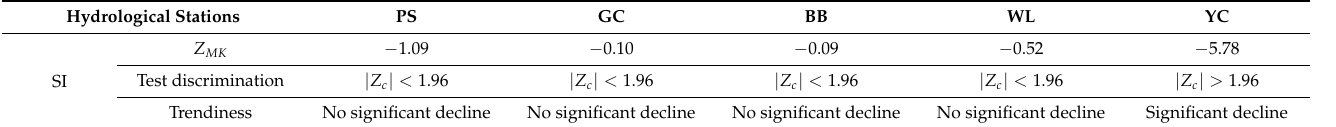
Table 4. TFPW–MK trend test of SI values in the upper reaches of the Yangtze River.